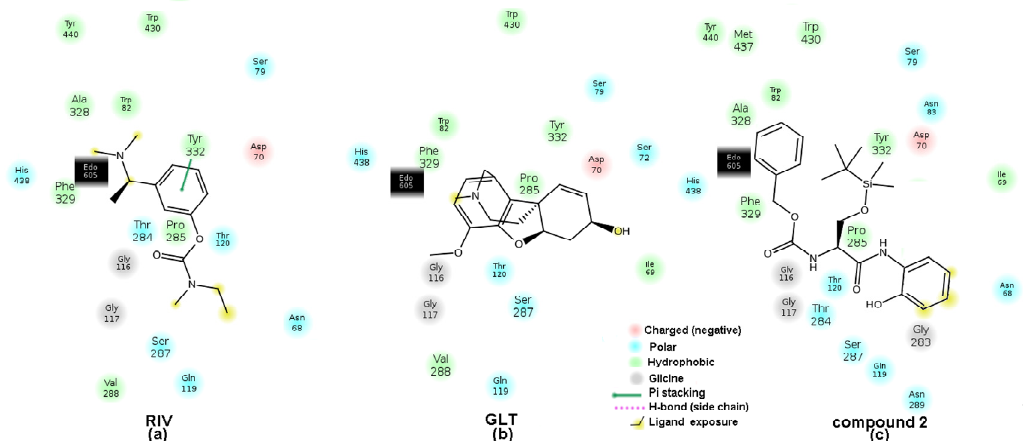
Figure 9. 2D-based comparison of binding pattern for RIV ( a ), GLT ( b ) and the most active BChE inhibitor, 2 , produced by the Maestro program.